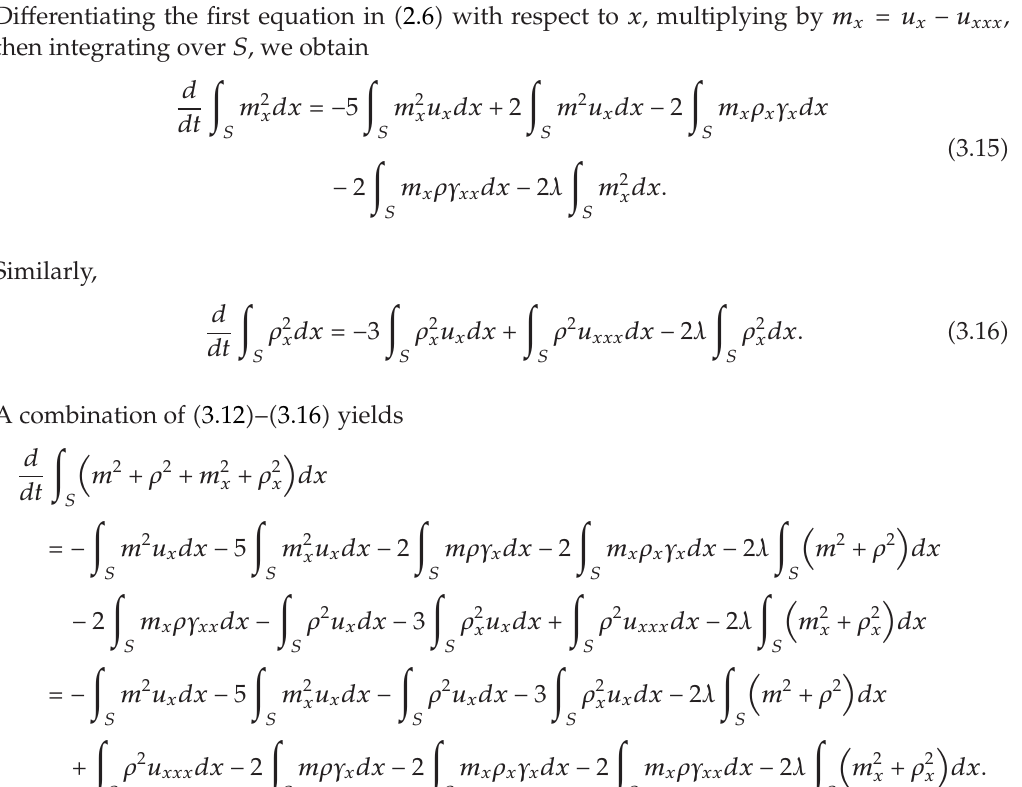
Di ff erentiating the first equation in (cid:4) 2.6 (cid:5) with respect to x , multiplying by m x (cid:3) u x − u xxx